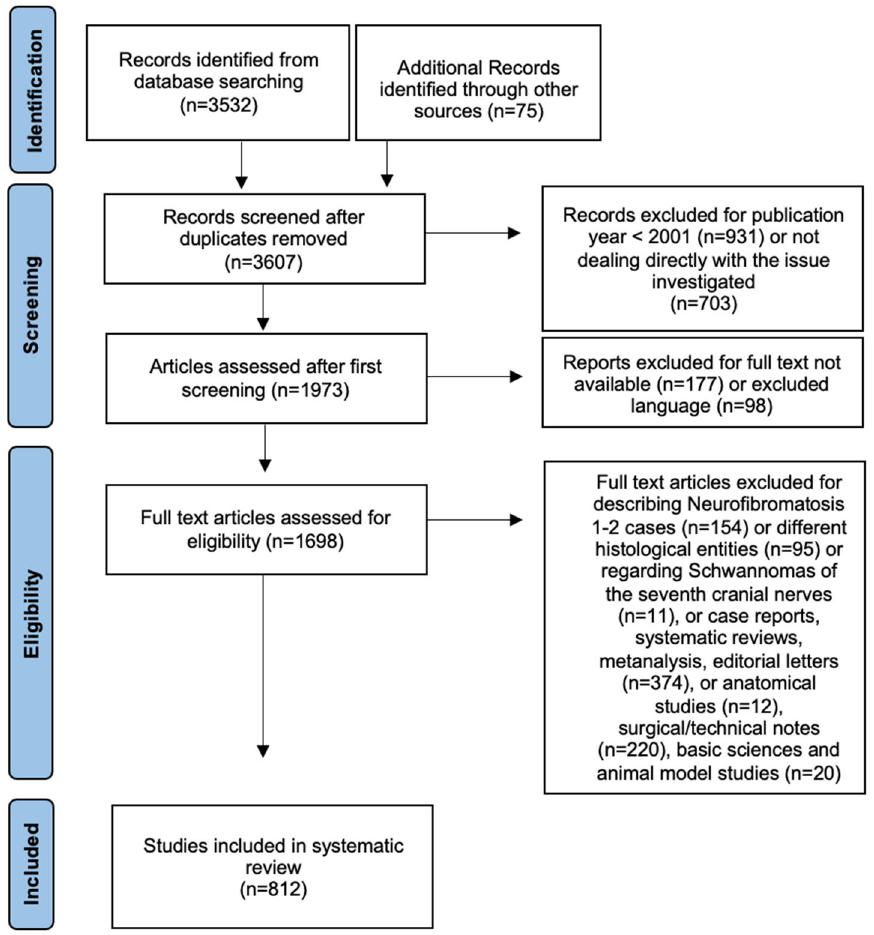
Figure 1. Flowchart of article search and selection according to the PRISMA Figure 1. flowchart of article search and selection according to the PRISMA criteria.